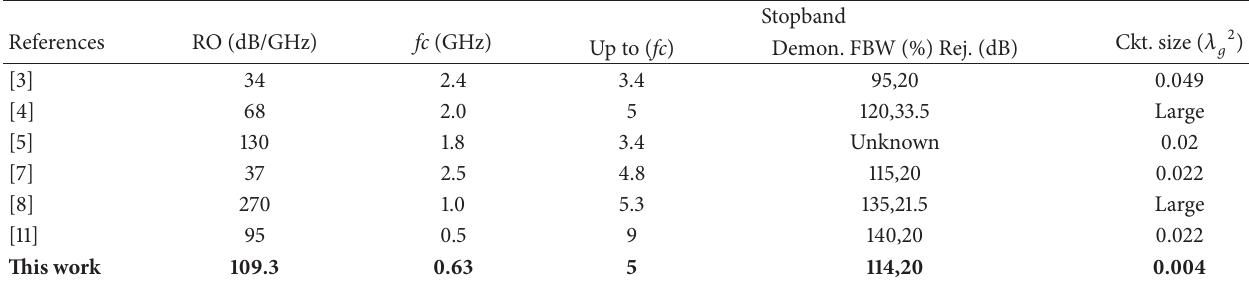
Table 1: Comparison with the reported LPFs.